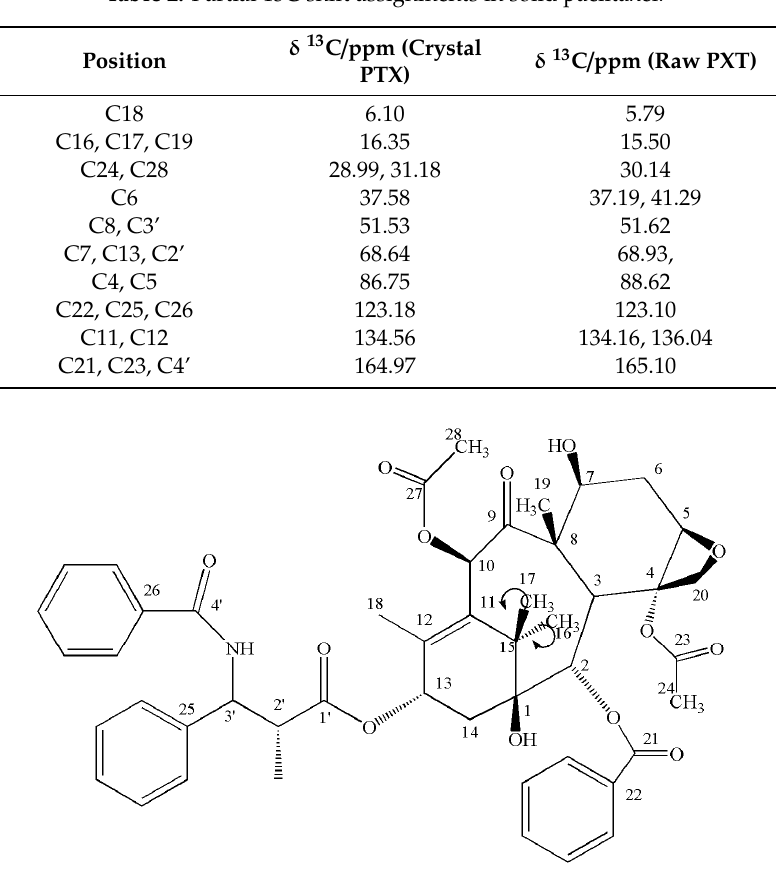
Table 2. Partial 13C shift assignments in solid paclitaxel.